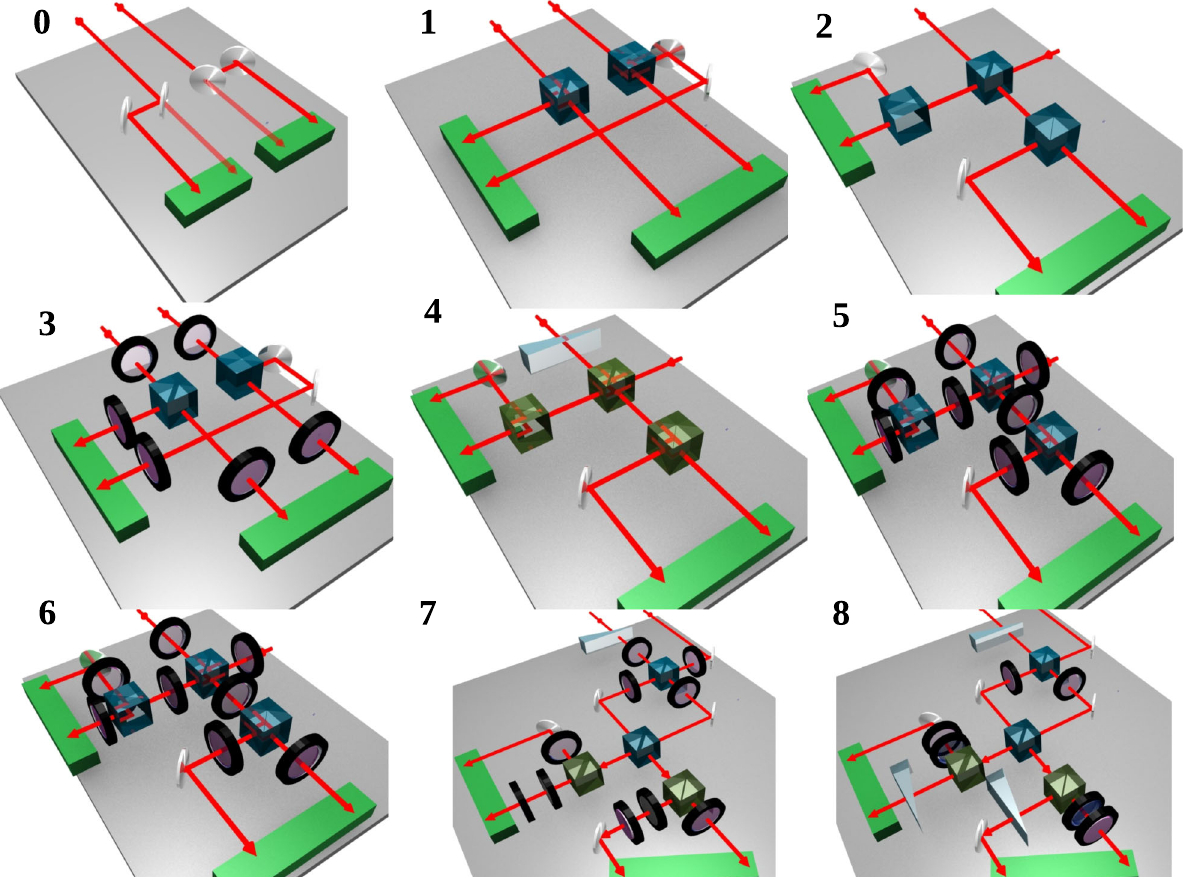
FIG. 4. Experimental setups for the observables in (4). For the measurement of observable 0, it is only necessary to distinguish between the paths r and t . To measure observable 4, a polarization-independent beam splitter is used to distinguish the eigenstates through interference. The measurements of observables 1 and 3 are standard polarization measurements using PBSs and HWPs. Observables 2, 5, and 8 are Bell-state measurements, and so are the measurements of 6 and 7, but in the latter group the Bell measurement is preceded by a rotation of the polarization to guarantee compatibility with observable 8. To measure the probabilities that appear in inequality (5), these measurement devices are arranged in a cascaded manner